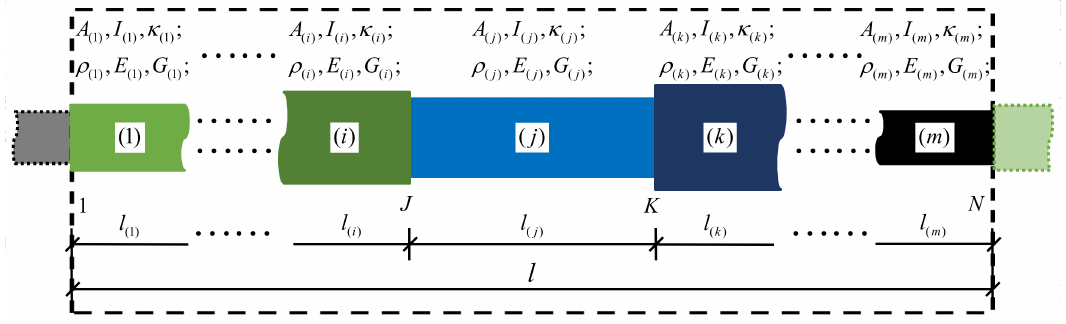
Figure 1. The schematic of a selective unit cell of an infinite bi-coupled periodic